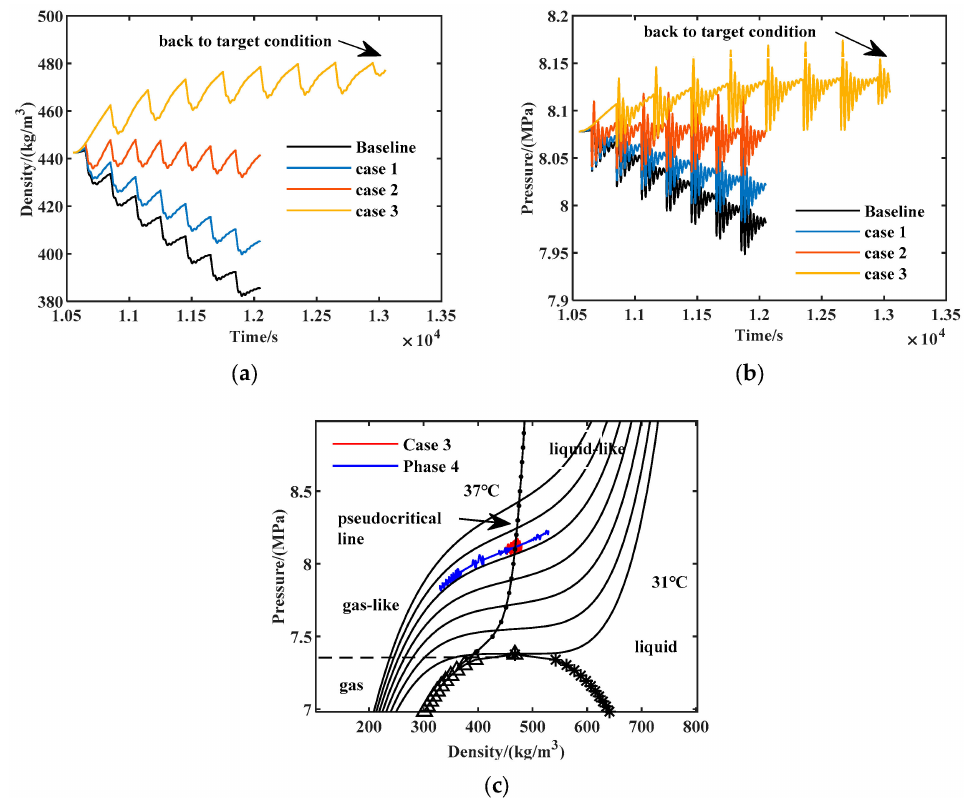
Figure 13. Comparison of various heating rates and speed-up rates when the system restarts from a warm state: ( a ) buffer tank density comparison; ( b ) buffer tank pressure comparison; ( c ) buffer tank pressure–density